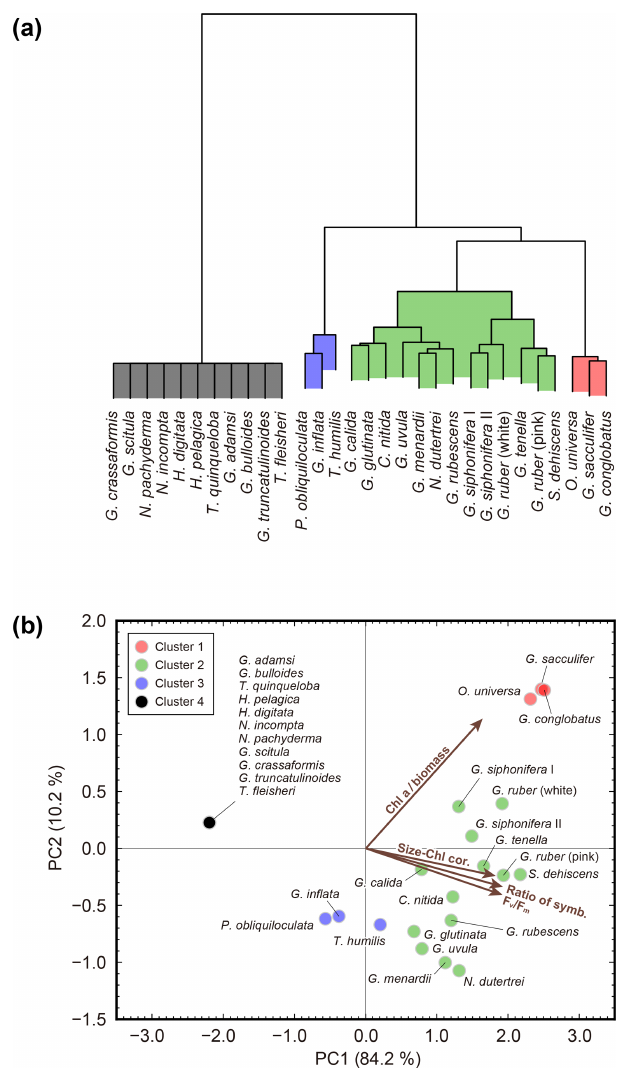
Figure 9. Results of cluster analysis and principal component anal- ysis. (a) Cluster dendrogram obtained using Ward’s method. (b) Bi- plot of principal component analysis. The colors of the symbols correspond to the four clusters. Vectors indicate the direction and strength of each variable to the overall distribution. The first axis explains 84.2% of the variation and the second axis 10.2% of the variation. Chl a / biomass: Chl a content per protein biomass esti- mated from test size of individuals; Size–Chl cor.: correlation coef- ficient of test size–Chl a content relationship as an indicator of the persistence of symbionts; Ratio of symb.: ratio of symbiotic indi- viduals; F v /F m : median F v /F m